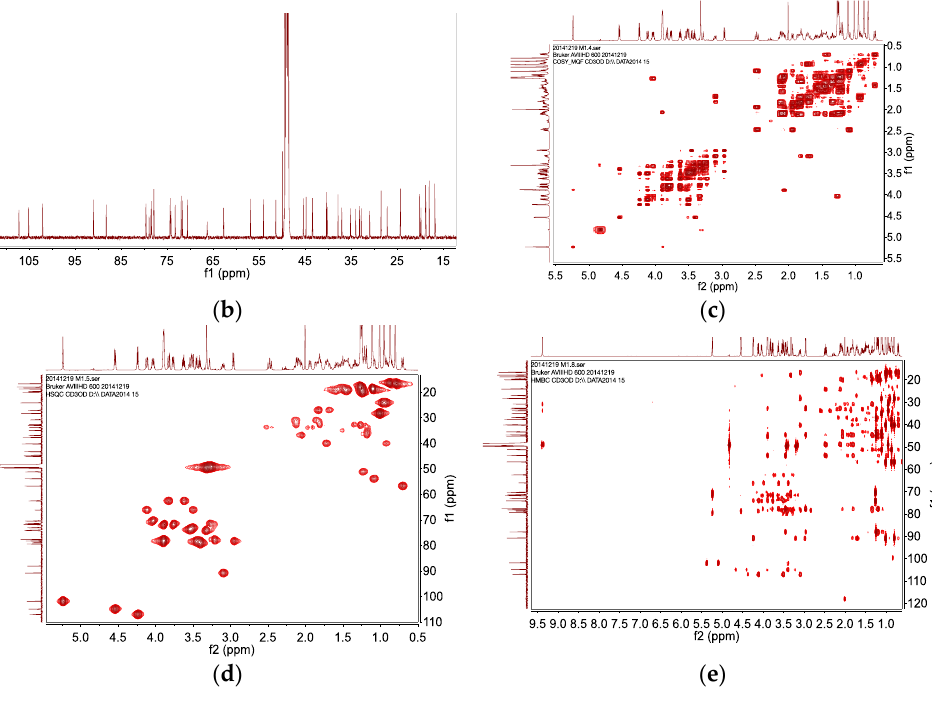
Figure 4. 1 H-NMR ( a ); 13 C-NMR ( b ); 1 H-COSY ( c ); HSQC ( d ); and HMBC ( e ) of ADS-I intestinal bacteria metabolite M1.